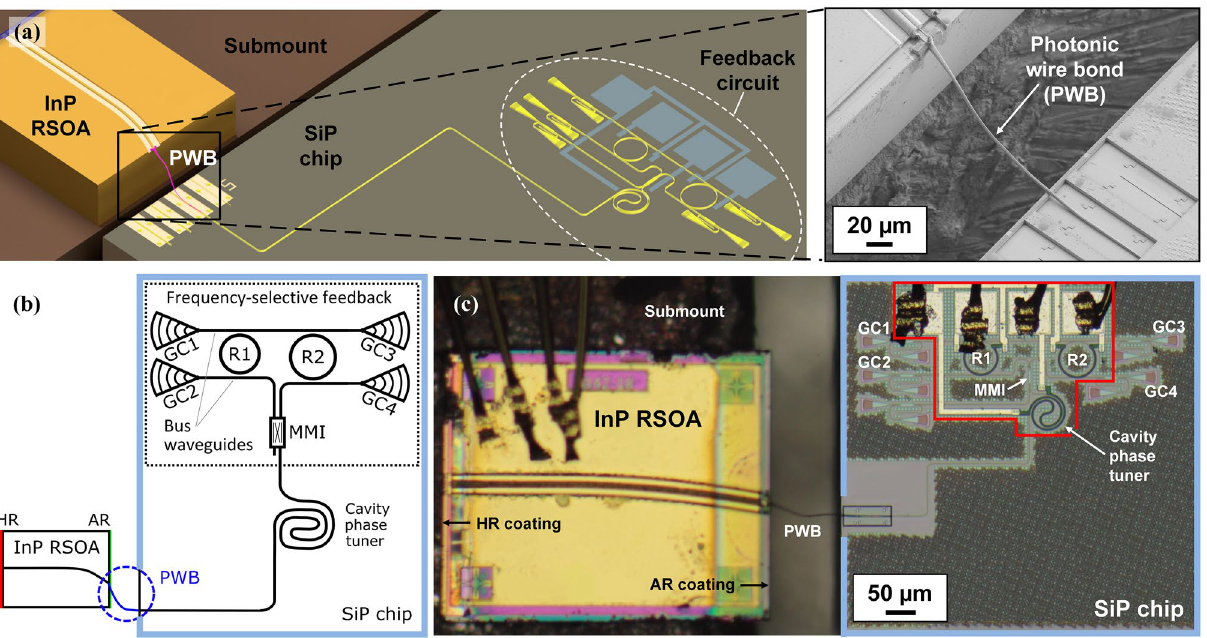
Figure 1. Concept and realization of a hybrid ECL with a photonic wirebond (PWB) as intra-cavity coupling element. ( a ) Concept: The device consists of an InP-based reflective semiconductor optical amplifier (RSOA) that is connected to a thermally tunable feedback circuit on a silicon photonic (SiP) chip. A photonic wire bond (PWB, see Inset) connects the facet of the RSOA to the SiP external-cavity feedback circuit. The assembly is built on a metal submount that simultaneously acts as an efficient heat sink. ( b ) Building blocks of the device realized for our proof-of-concept demonstration. The 600 µm-long RSOA is equipped with a high-reflectivity (HR) coating at the back facet. The front facet is angled (tilt angle 9°) and anti-reflection-(AR)-coated with respect to polymer (refractive index n = 1.56). The SiP external-cavity circuit (framed in light blue) comprises a 350 µm-long spiral-shaped phase shifter for adjusting the intra-cavity phase (cavity phase tuner) and a tunable frequency-selective feedback structure. Frequency selectivity is provided by two symmetrically coupled Vernier ring resonators R1 and R2 in add-drop configuration with diameters D 1 = 62 µm (R1) and D 2 = 67 µm (R2) and with coupling gaps of 180 nm. Note that the cascaded Vernier rings can be assumed to be reciprocal, such that the feedback circuit behaves similarly to a Sagnac loop mirror. The lower left-hand input port of the 2 × 2 MMI can thus in principle be left unconnected, and the associated grating coupler shown in Subfigure ( a ) was omitted here for simplicity. ( c ) Microscope image of the assembled device. Left-hand side: InP RSOA; right-hand side: SiP chip (framed light blue). The relevant part of the external-cavity circuit is marked by a red bounding